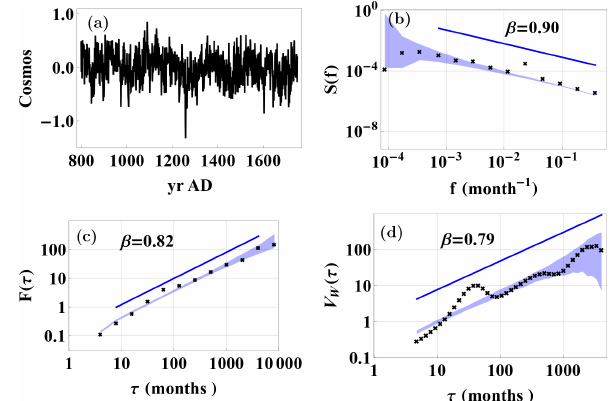
Figure 5. (a) Temperature from the LOVECLIM experiment with 1-year resolution (black) and deterministic response (red). (b) The residual from the deterministic response. (c) PSD from the residual (black crosses) and linear fit to the PSD in the scale range indicated by the red line segment. The value β = 1 . 07 estimated from this line segment is indicated in the figure. (d) DFA2 applied to the residual (black crosses). The straight line segment is a linear fit to the dots in the range indicated by the length, and position of the line segment and the slope yields an alternative estimate β = 1 . 01 for the resid- ual, indicated in the figure. The shaded area in (c) and (d) is the 95% confidence range for synthetic fGn with β = 0 . 95 estimated by MLE using the response model.